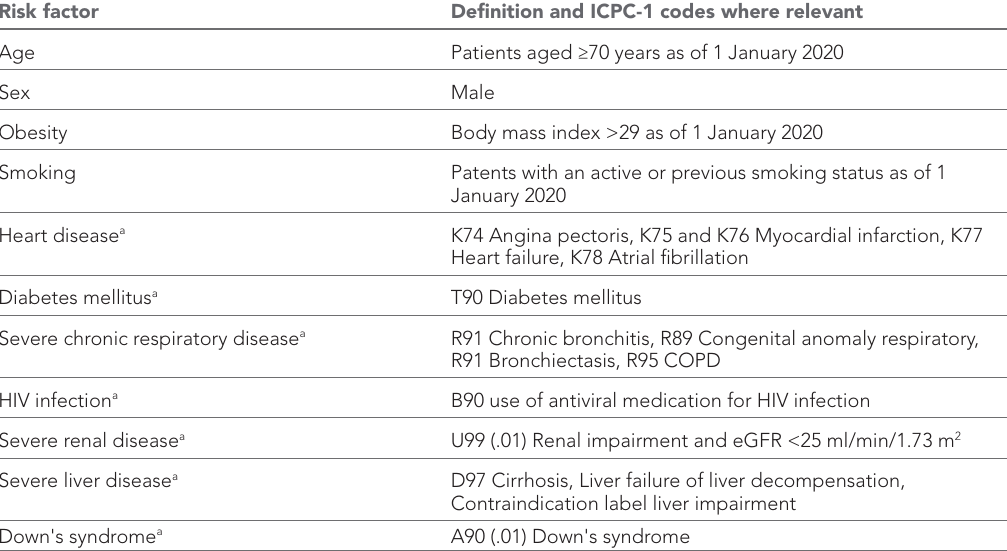
Table 2 Definition of risk factors for adverse course of COVID-